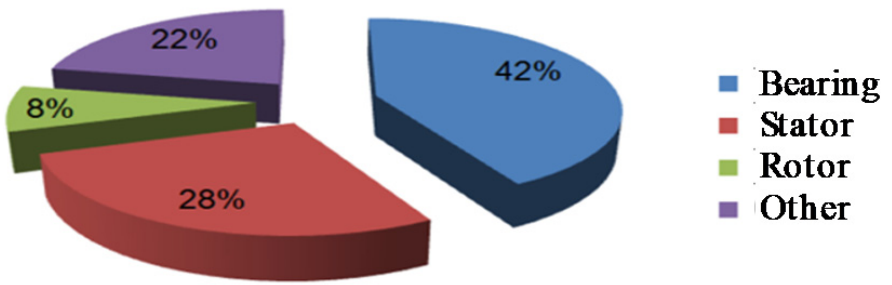
Figure 1. Induction Motor Fault Type Statistics.